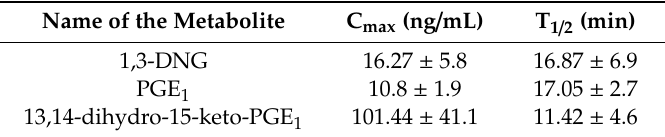
Table 1. Pharmacokinetic parameters of the identified Prostanit metabolites.